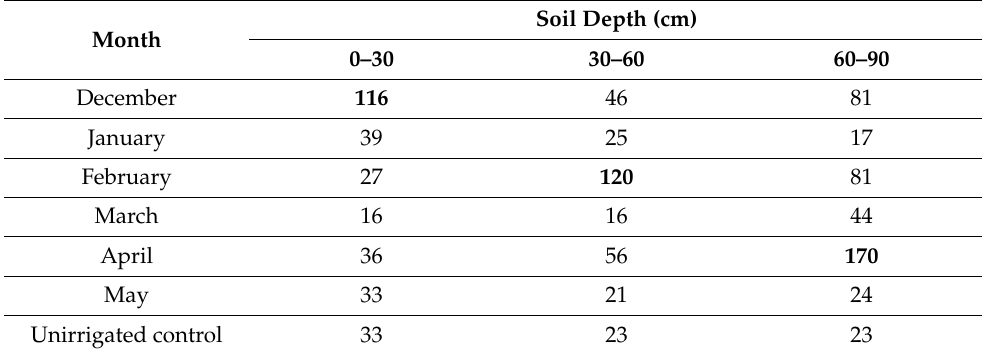
Table 4. Changes in Bray-1 extractable P levels (mg · kg − 1 ) with soil depth over time in a bleached (Albic/E) soil irrigated with winery effluent (extracted and adapted from Mulidzi [37]).